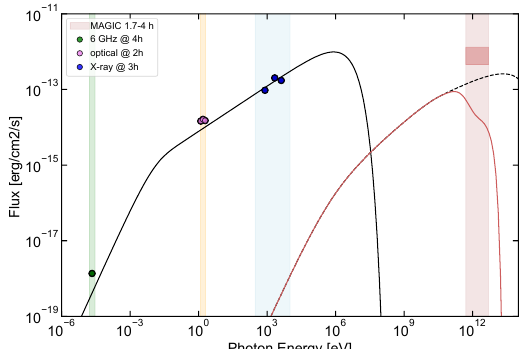
Figure 12. GRB 160821B: modeling of the simultaneous multi-wavelength SED at approximately ∼ 3 h according to [145] (©AAS. Reproduced with permission.), for the same parameters used to model the lightcurves in Figure 11. The shaded areas show the sensitivity energy range of the different instruments. The MAGIC error box on the reconstructed flux is also shown. Synchrotron (solid black line), intrinsic SSC (before EBL absorption, dashed black line) and SSC emission with EBL attenuation (solid red line) estimated from the numerical modeling are